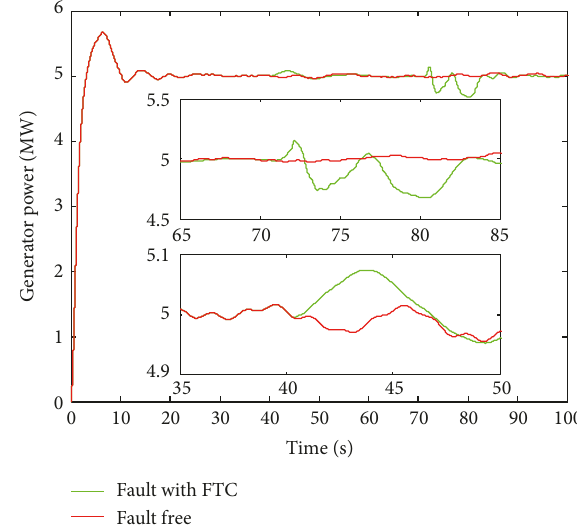
Figure 8: Generator power output with 𝑓 𝑠 = − 0.3.